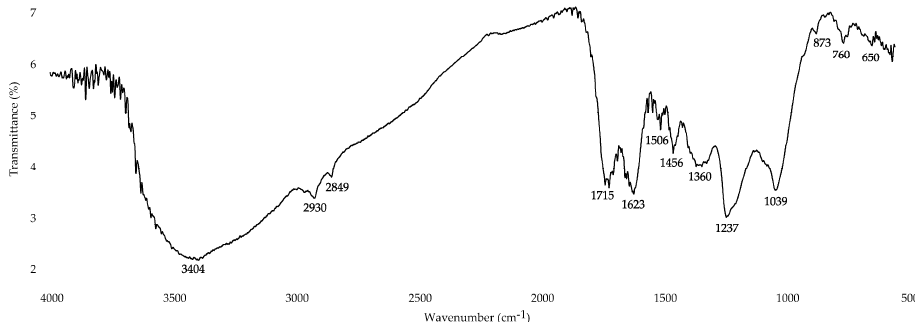
Figure 6. Fourier-transform infrared spectrum of E. angustifolium melanoidin (EAM). As for the vibrations in the range of 1506–1522 cm − 1 , they resulted from the system of aromatic rings and COOH groups not from amide II, due to the low nitrogen content in the EAM. Signals in the region below 880 cm − 1 were caused by the aromatic protons of the melanoidin skeleton, and the weak bands at 2849–2970 cm − 1 were caused by the aliphatic fragments C=H, CH 2 , and CH 3 , which have a low content